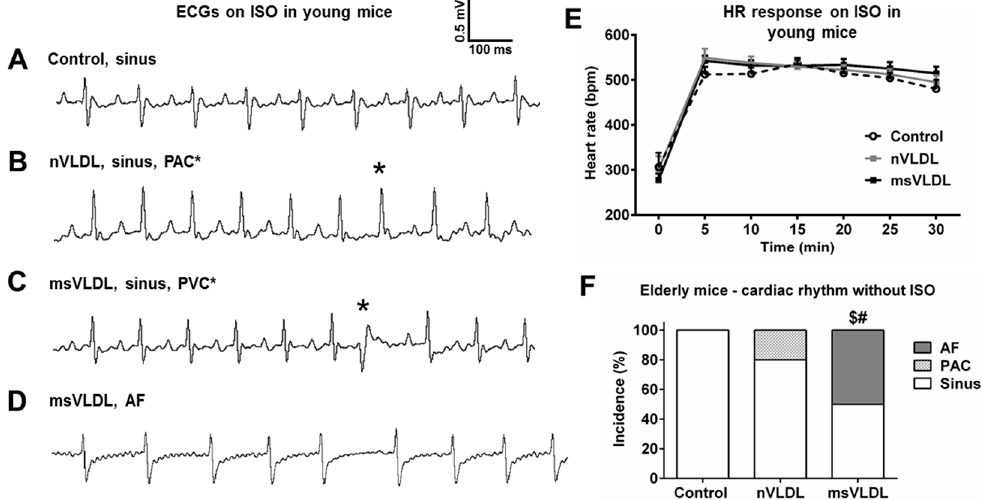
Figure 3. Isoproterenol-induced and unprovoked atrial fibrillation (AF) were observed only in msVLDL mice. ( A – D ) Representative tracings of young mice after ISO injection show abnormalities including normal regular sinus rhythm in the control group ( n = 5), premature atrial complex (PAC) in the nVLDL group, premature ventricular complex (PVC *) and AF (absence of clear P waves and irregular RR intervals) in the msVLDL group ( n = 5); ( E ) Heart rate responses after isoproterenol injection were not different among groups; ( F ) For elderly mice, spontaneous, unprovoked AF was noted in the msVLDL group ( n = 6) with an incidence of 50%. PAC was observed in one mouse in the nVLDL group ( n = 5). All control mice ( n = 5) had sinus rhythm. $ p < 0.001 for msVLDL vs. control and # p < 0.001 for msVLDL vs. nVLDL.